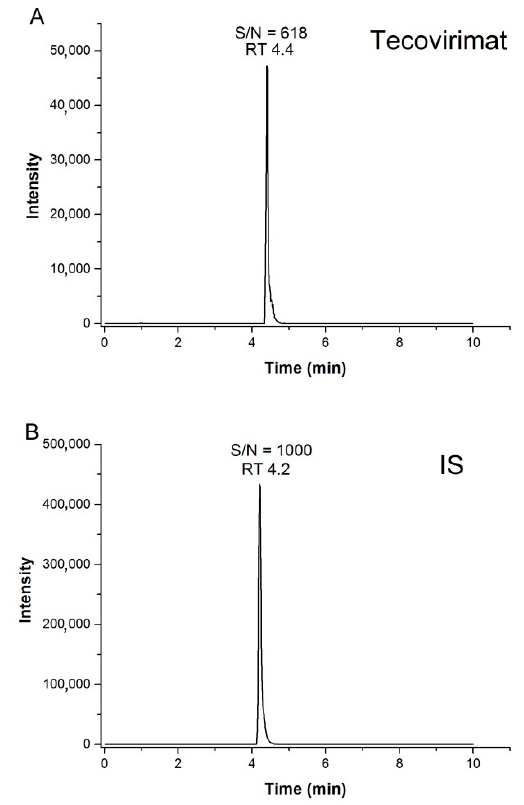
Figure 3. Representative chromatograms of ST-246 at the LOQ (10 ng/mL; panel ( A )) and of the IS at 30 ng/mL ( B ) with the corresponding retention time (RT) and signal-to-noise (S/N) ratio.